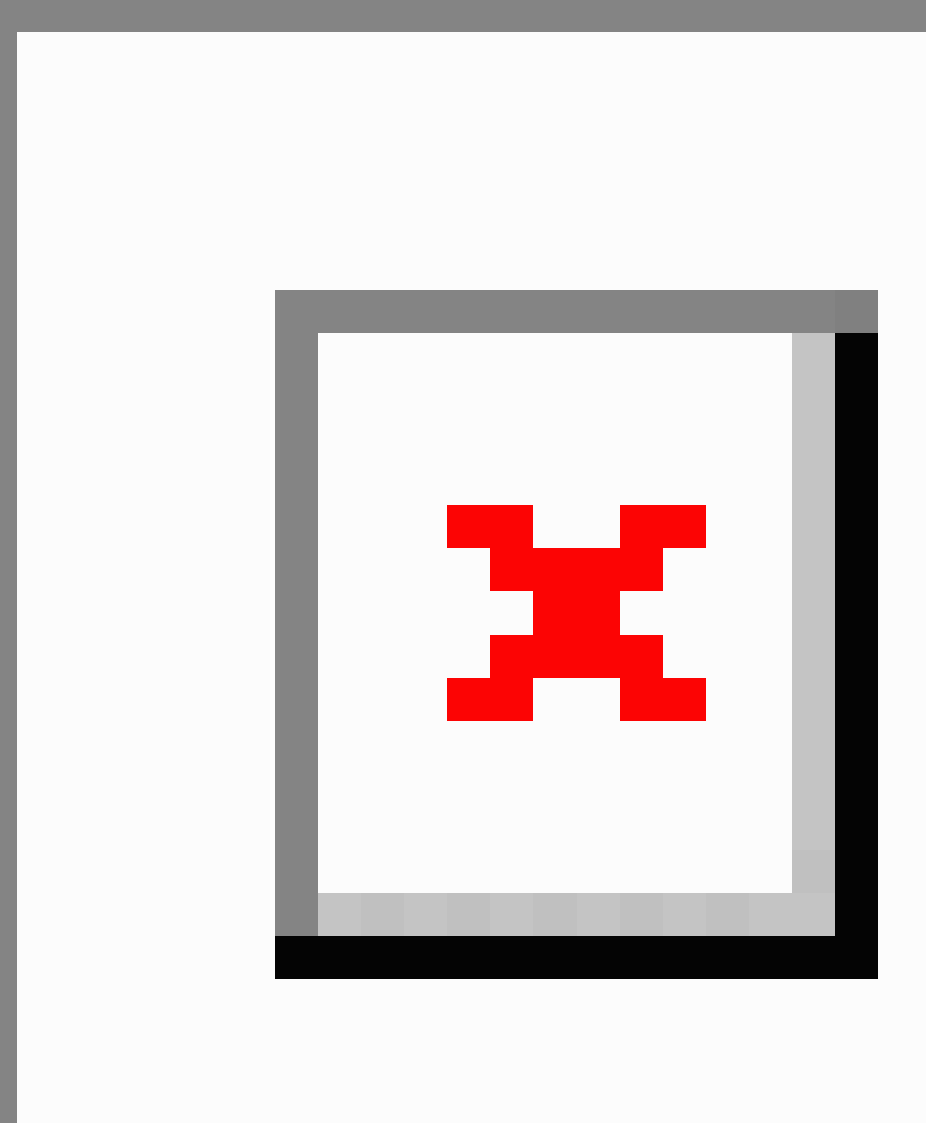
Figure 1. Overview of the technology underpinning Paola, the virtual health